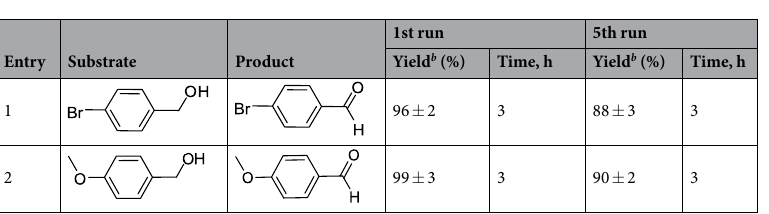
Table 3. Recovery test of aluminum oxy-hydroxide-supported palladium nanoparticles. a Unless otherwise